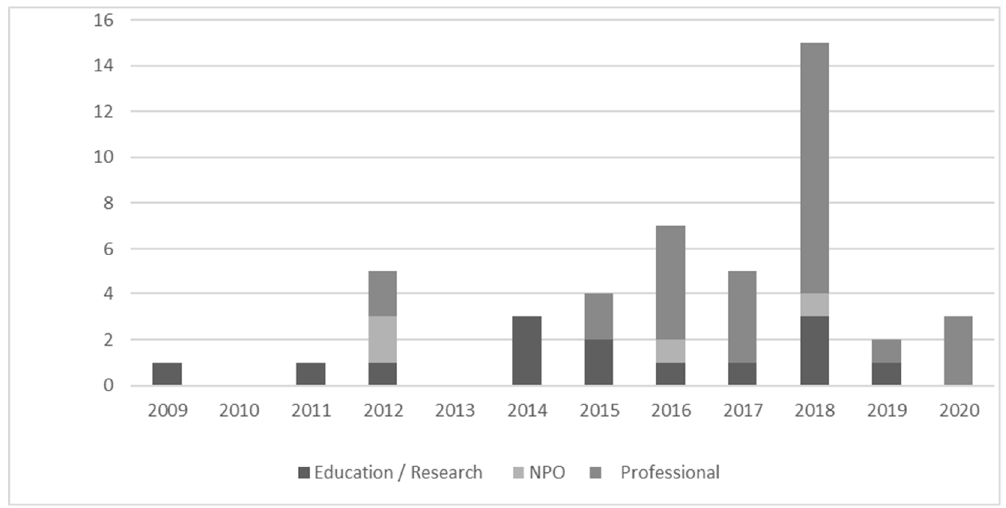
Figure 2. Year of creation of aquaponics system.